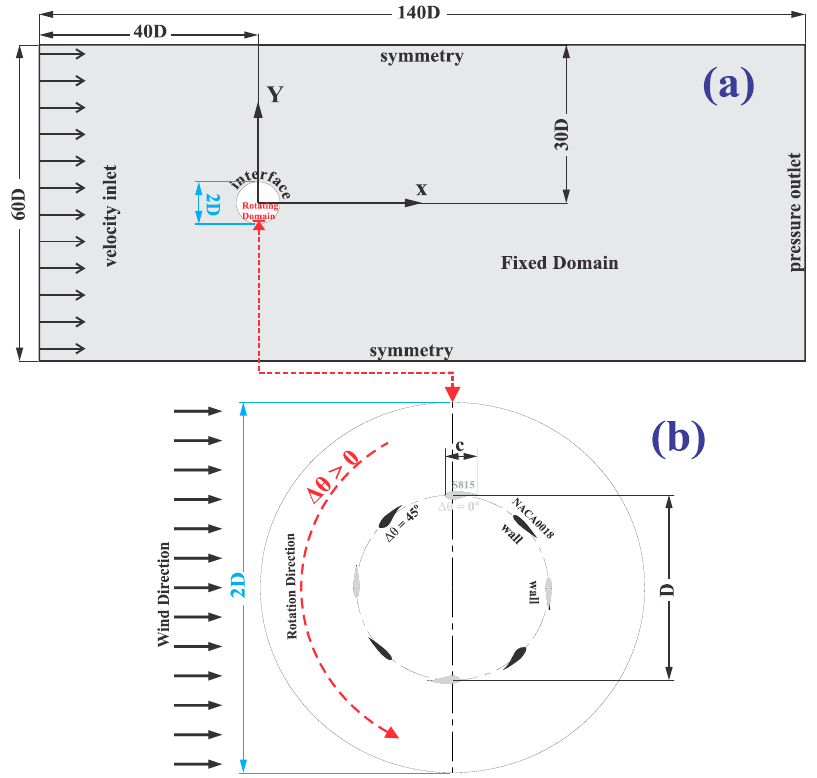
Figure 2. Domain and boundary conditions: ( a ) whole view of the domain; ( b ) close view of the rotating domain of